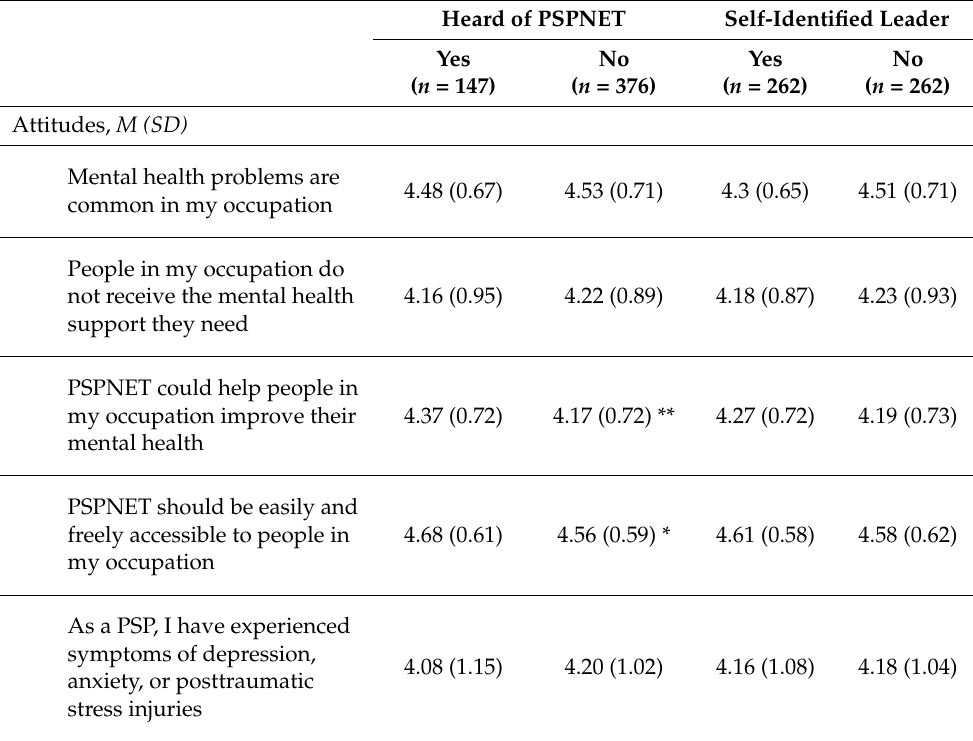
Table 2. Perceptions of need for mental health and ICBT.